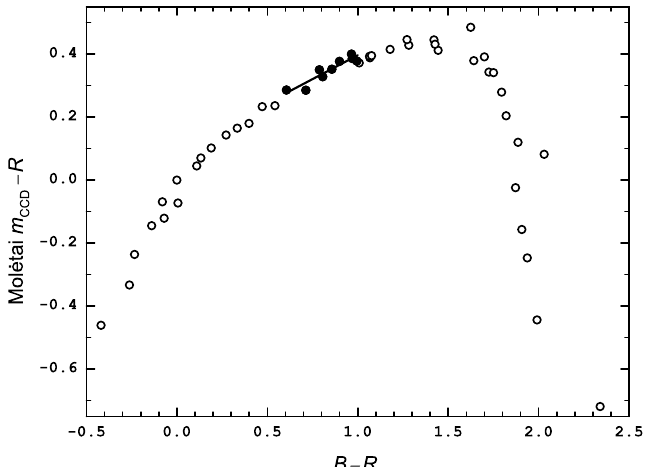
B R Fig. 5. Synthetic color equation between the POSS-2 magnitudes R and CCD magni- tudes of the Mol˙etai Observatory. The filled circles denote the interval of B – R in which comparison stars were selected. APPHOT, a subroutine of the IRAF software in the circular aperture mode.